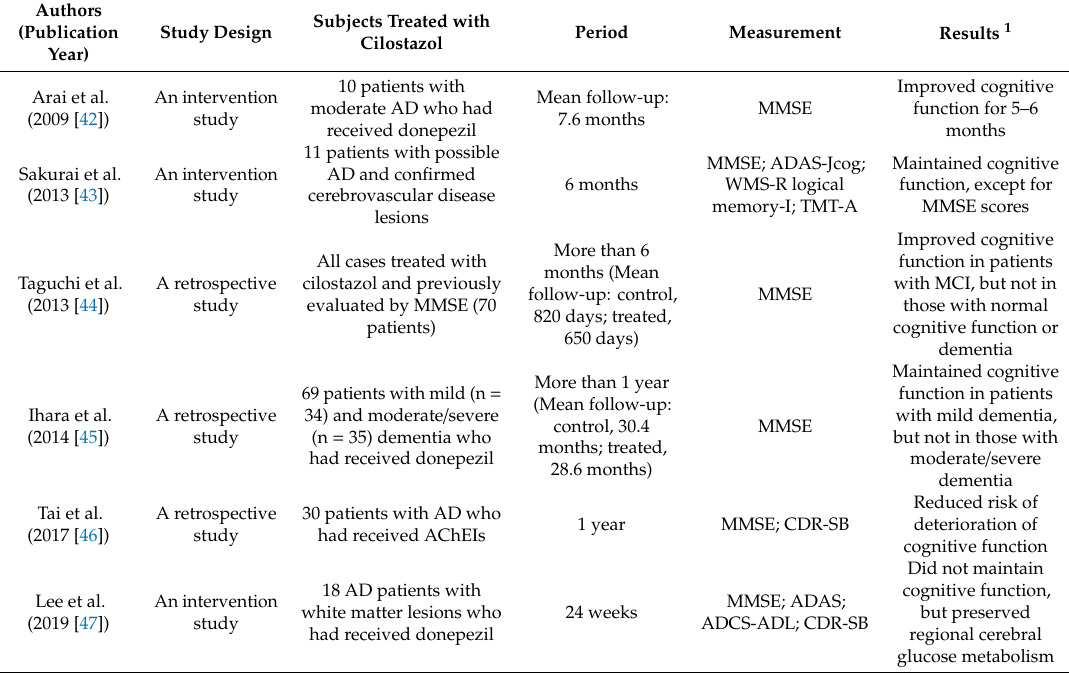
Table 1. E ff ects of cilostazol on cognitive function in patients with AD or mild, moderate, and / or severe